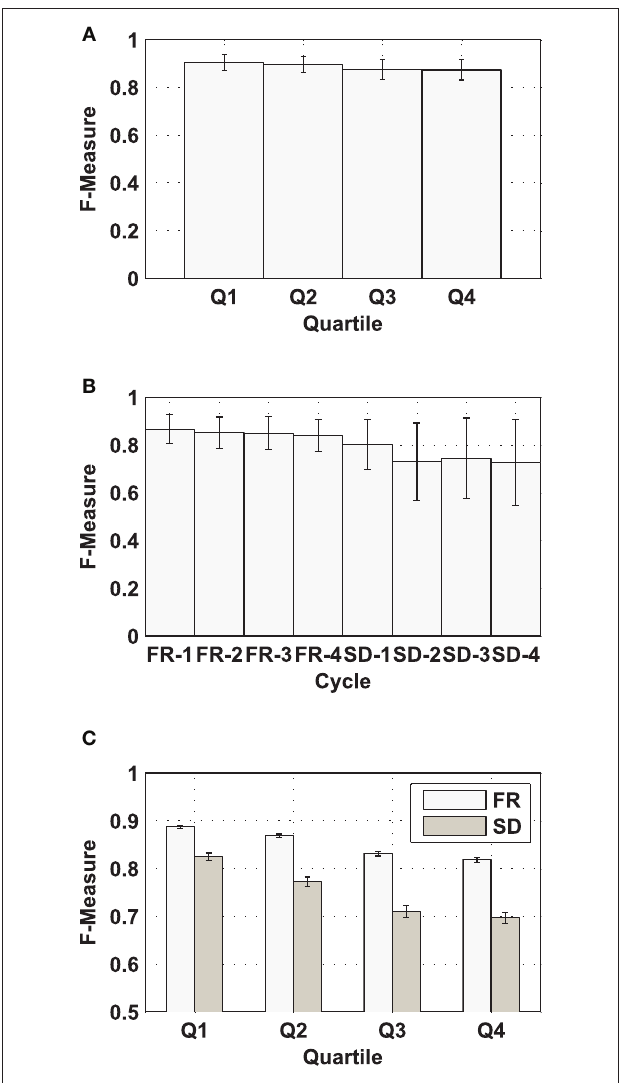
Figure 1 | Performance on the 3CVT. (A) F -Measure (mean ± STD) per quartile (Q1–Q4) for the BL sessions, (B) F -Measure (mean ± STD) for each cycle of the FR and SD sessions, (C) F -Measure (mean ± SEM) for each 3CVT quartile (Q1–Q4) over the FR and